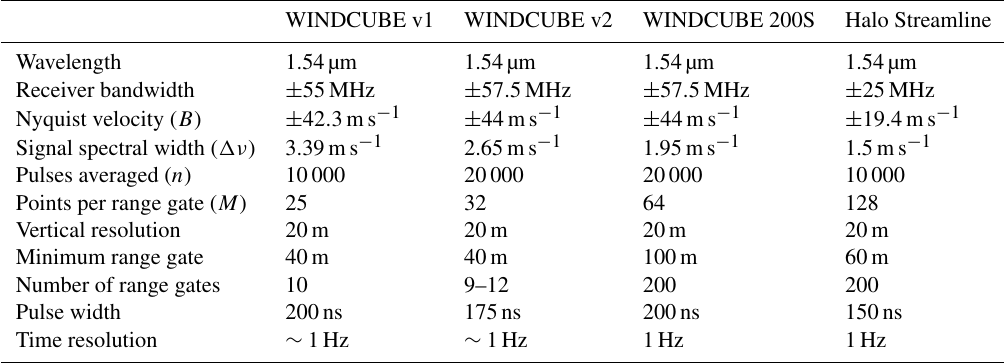
Table 2. Main technical specifications of the lidars used in this study. WINDCUBE v1 WINDCUBE